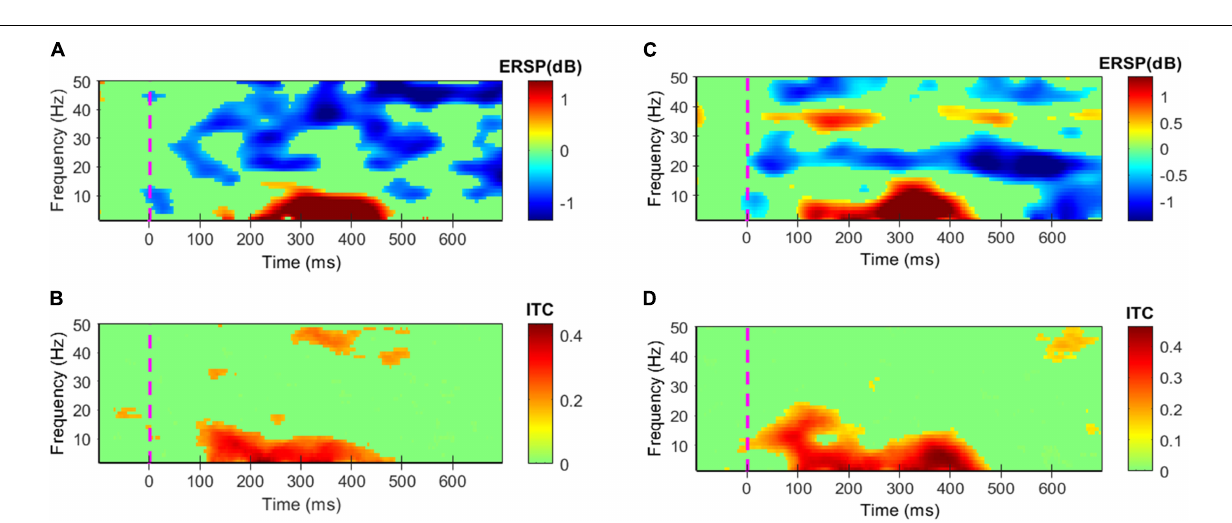
FIGURE 4 | Grand average ERPs’ Event-related spectral perturbations (ERSPs) and inter-trial coherence (ITC). All colors except green shows statistically significant values at α = 0.05. (A,B) Depict ERSPs and ITC patterns for the failure events, respectively. (C,D) Depict ERSPs and ITC patterns for the success events